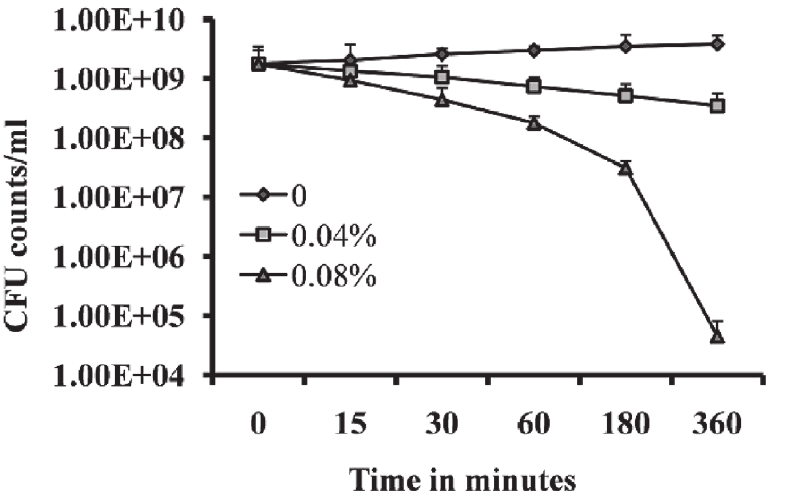
Fig 4. Time-course of the bactericidal effect within established S. aureus (ATCC 29213) biofilms. The pre-established biofilms were treated with MIC or 2×MIC eugenol and the cell viability was expressed as cfu counts at different time intervals. The control sample was untreated. The error bars represent standard deviation from mean value. The experiment was performed in triplicate and repeated 3